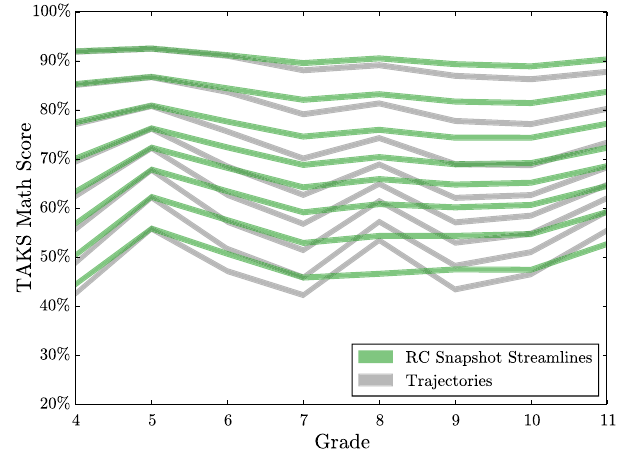
FIG. 10. RC snapshot streamlines for 2003 – 2005 and trajecto- ries for the 2012 cohort. The 8th grade peaks observed in the lower-performing trajectories (2008), which are missing in the RC snapshot streamlines (2003 – 2005), are a result of the Student Success Initiative and the Accelerated Mathematics Instruction, which was provided to low-performing 8th grade students starting in